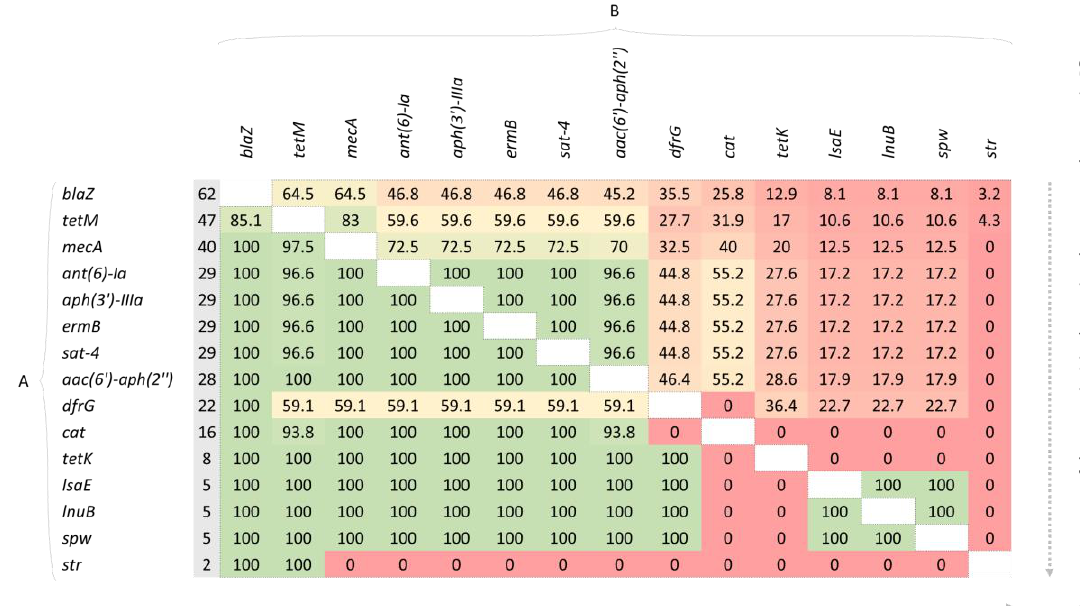
Figure 2. Cooccurrences (%) of the antibiotic resistance genes (ARGs). Seventeen genes were detected within the 67 S. pseudintermedius isolates. blaI and blaR1 are not shown in the figure since they share the same presence as blaZ . The second column (in gray) indicates the number of isolates harboring the gene. The % values are calculated by dividing the number of cooccurrences of two given genes by the number of times a gene is present in our isolates. As an example, all the isolates presenting mecA (40), also present the gene blaZ (100% of cooccurrence); however, only 40 out of the 62 isolates presenting blaZ also present the mecA gene (64.5% of cooccurrence). For all the data and how it is calculated, see Supplementary Table S2.